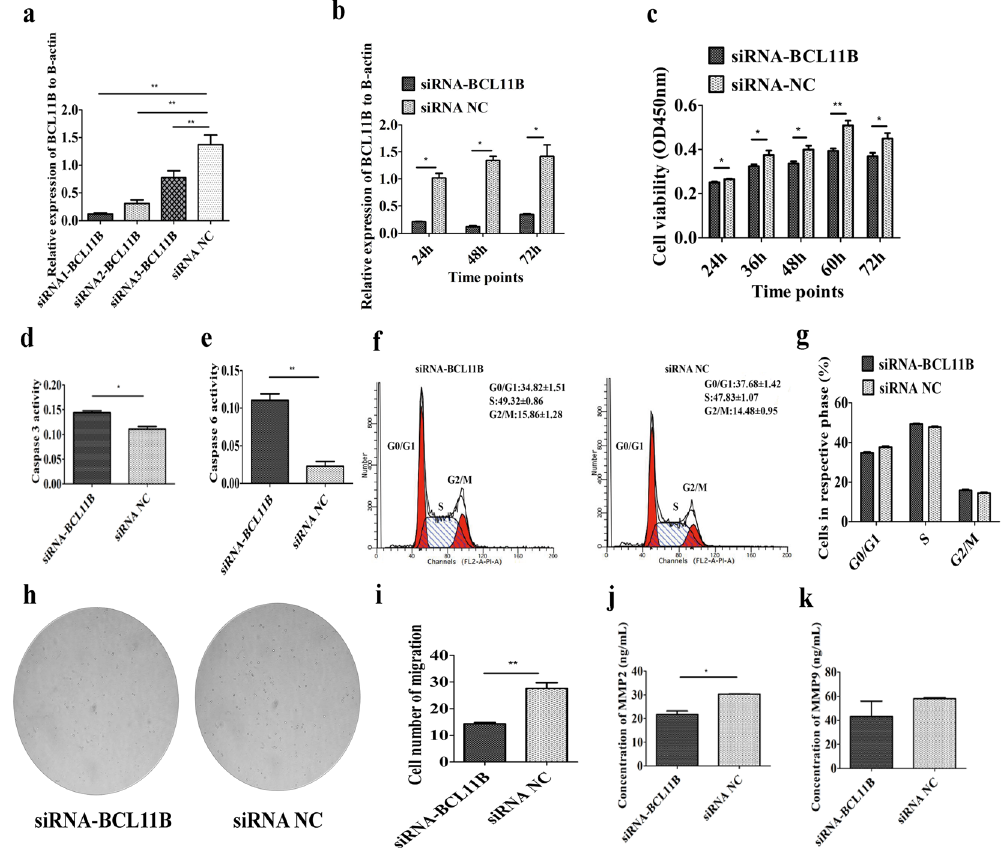
Figure 4. Effect of BCL11B knockdown on cell proliferation, migration and invasion in MSB1 cells. ( a ) Interference efficiency of three siRNAs designed to interfere with BCL11B determined by qRT-PCR (n = 4). ( b ) Diagrams of the siRNA-BCL11B interference efficiency on BCL11B determined by qRT-PCR (n = 4). ( c ) Effect of BCL11B knockdown on MSB1 cell proliferation. Cell proliferation was detected by CCK-8 assay at 24 h, 36 h, 48 h, 60 h and 72 h after transfection with siRNA-BCL11B and siRNA NC (n = 5). ( d,e ) Effect of BCL11B knockdown on MSB1 cell apoptosis. The activity of caspase-3 ( d ) and caspase-6 ( e ) was detected after transfection with siRNA-BCL11B and siRNA NC (n = 3). ( f ) Representative histograms depicting cell cycle profiles of MSB1 cells transiently transfected with siRNA-BCL11B and siRNA NC (n = 3). ( g ) Proportion of cells in various phases of the cell cycle (n = 3). ( h ) Representative images depicting cell migration profiles of MSB1 cells transiently transfected with siRNA-BCL11B and siRNA NC (n = 2). ( i ) Effect of BCL11B knockdown on MSB1 cell migration. Transwell migration assay of MSB1 cells was performed after transduction of siRNA-BCL11B and siRNA NC (n = 2). ( j,k ) Protein level of MMP2 ( j) and MMP9 ( k) after transduction of siRNA-BCL11B and siRNA NC (n = 4). Differences between two groups were analysed by Student’s t -test with the SAS system. The data are expressed as the mean ± S.E. * P < 0.05. ** P <